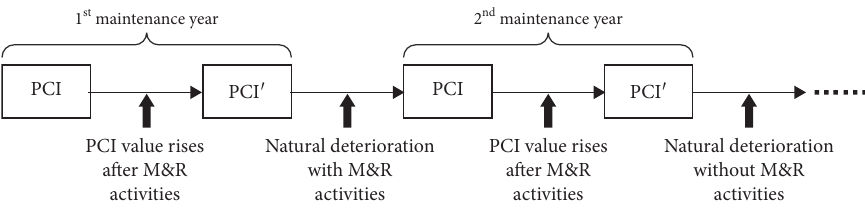
Figure 1: Flow of pavement performance changes. PCI ′ is the PCI value after the M&R